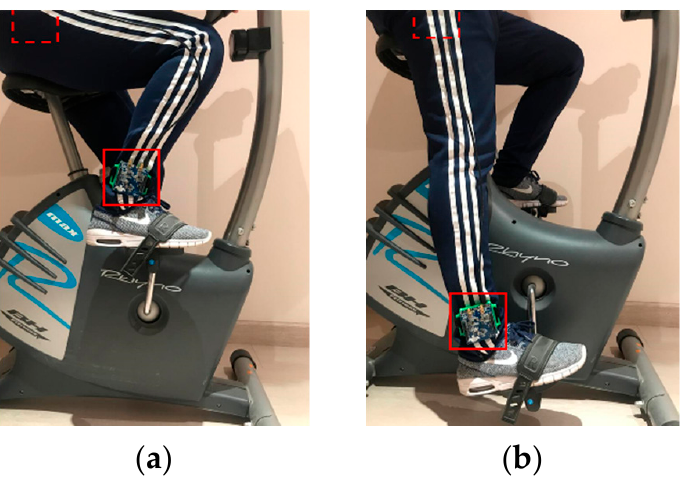
Figure 3. Node positions in the cycling scenario: ( a ) point of minimum distance, ( b ) point of maximum distance.